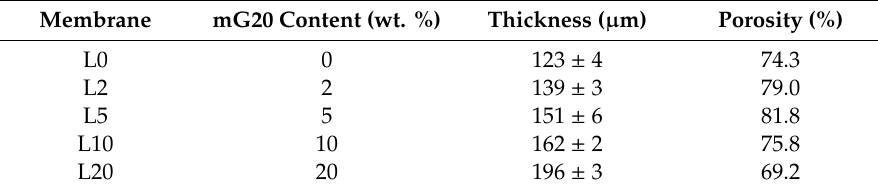
Table 1. Composition and morphological characteristics of the investigated membranes.